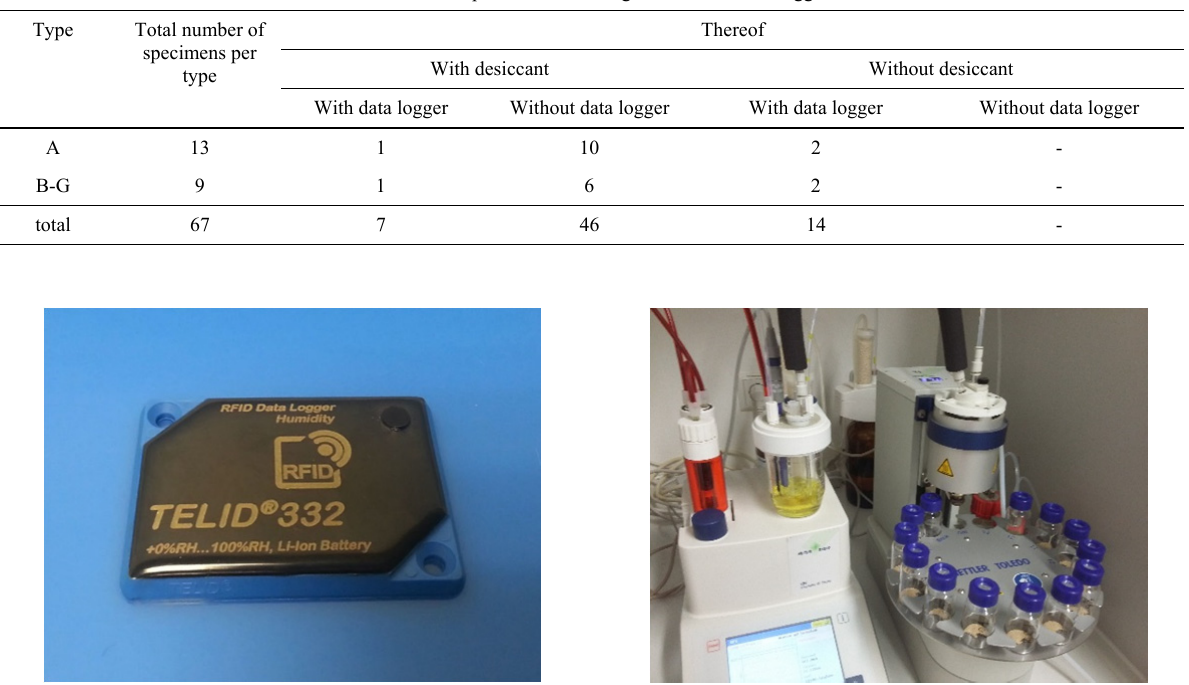
Table 3: Tested specimens according to the use of data